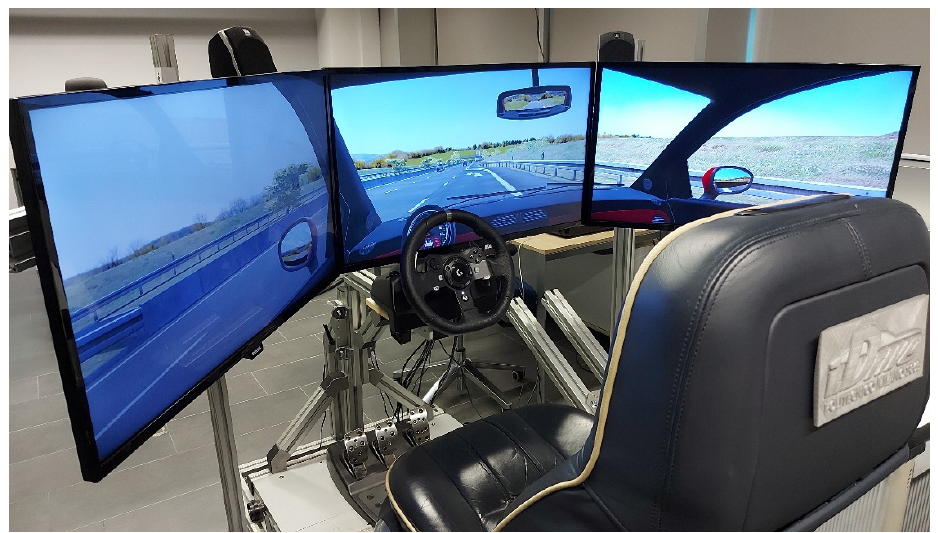
Figure 1. View of the iDrive driving simulator.